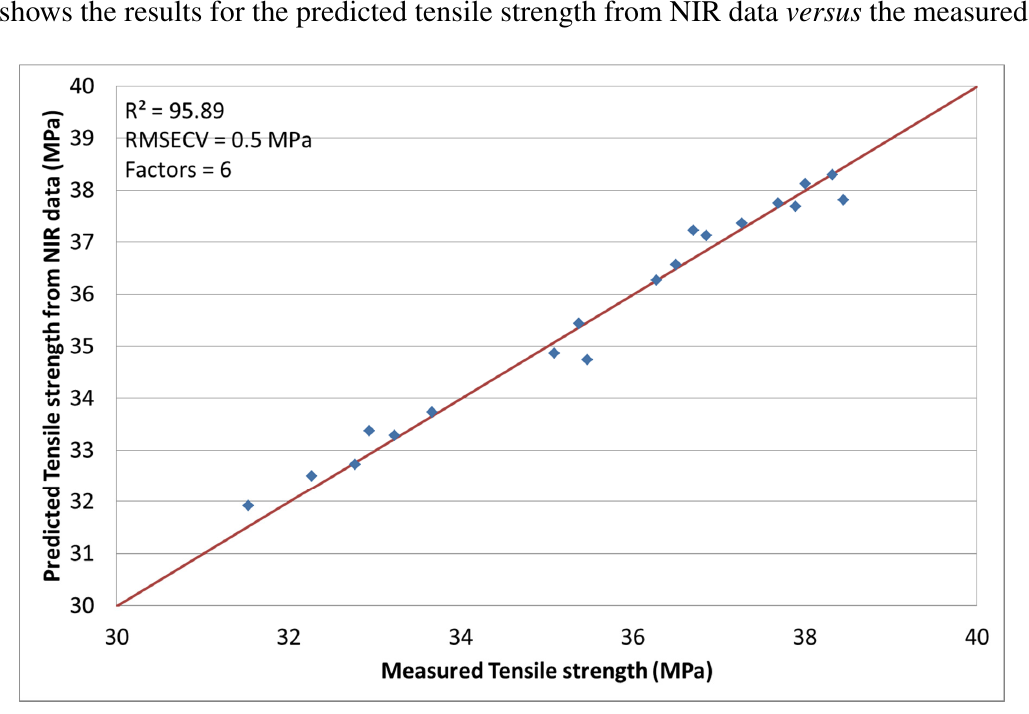
Figure 2. Predicted tensile strength values by NIR versus measured.